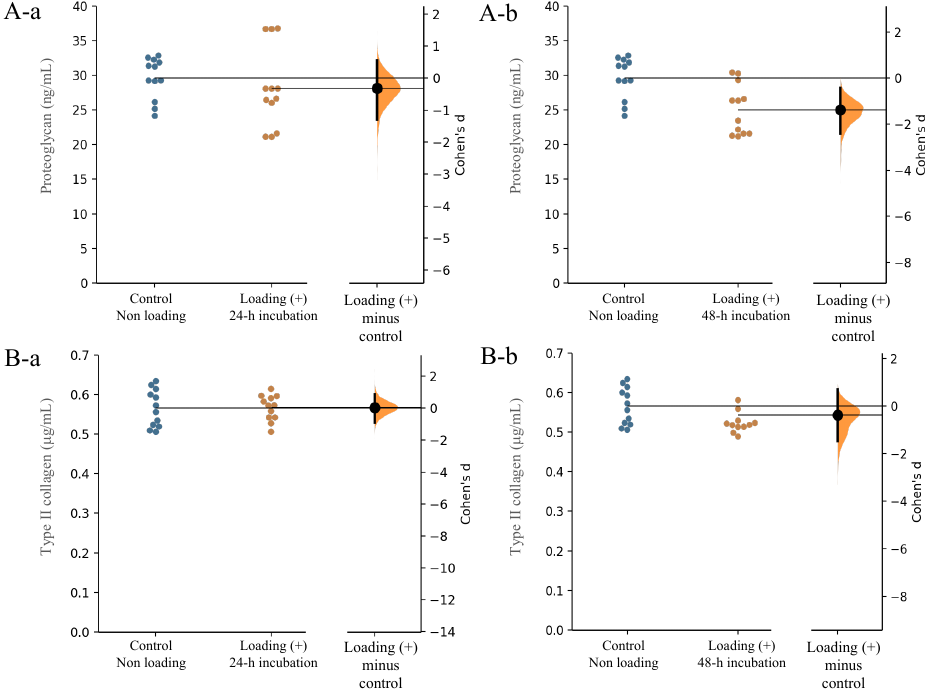
Figure 4. Effects of mechanical loading on chondrocyte activity. Effects of mechanical loading on osteoblast activity. Cohen’s d between the control and mechanical loading group is shown in the above Gardner–Altman estimation plot. Both groups are plotted on the left axes; the mean difference is plotted on a floating axes on the right as a bootstrap sampling distribution. The mean difference is depicted as a dot; the 95% confidence interval is indicated by the ends of the vertical error bar. The effect sizes and CIs are reported above as effect size (CI width lower bound; upper bound). ( A ) Proteoglycan: ( a ) control group versus mechanical loading (+)-24 h incubation group, ( b ) control group versus mechanical loading (+)-48 h incubation group. ( B ) Type II collagen: ( a ) control group versus mechanical loading (+)-24 h incubation group, ( b ) control group versus mechanical loading (+)-48 h incubation